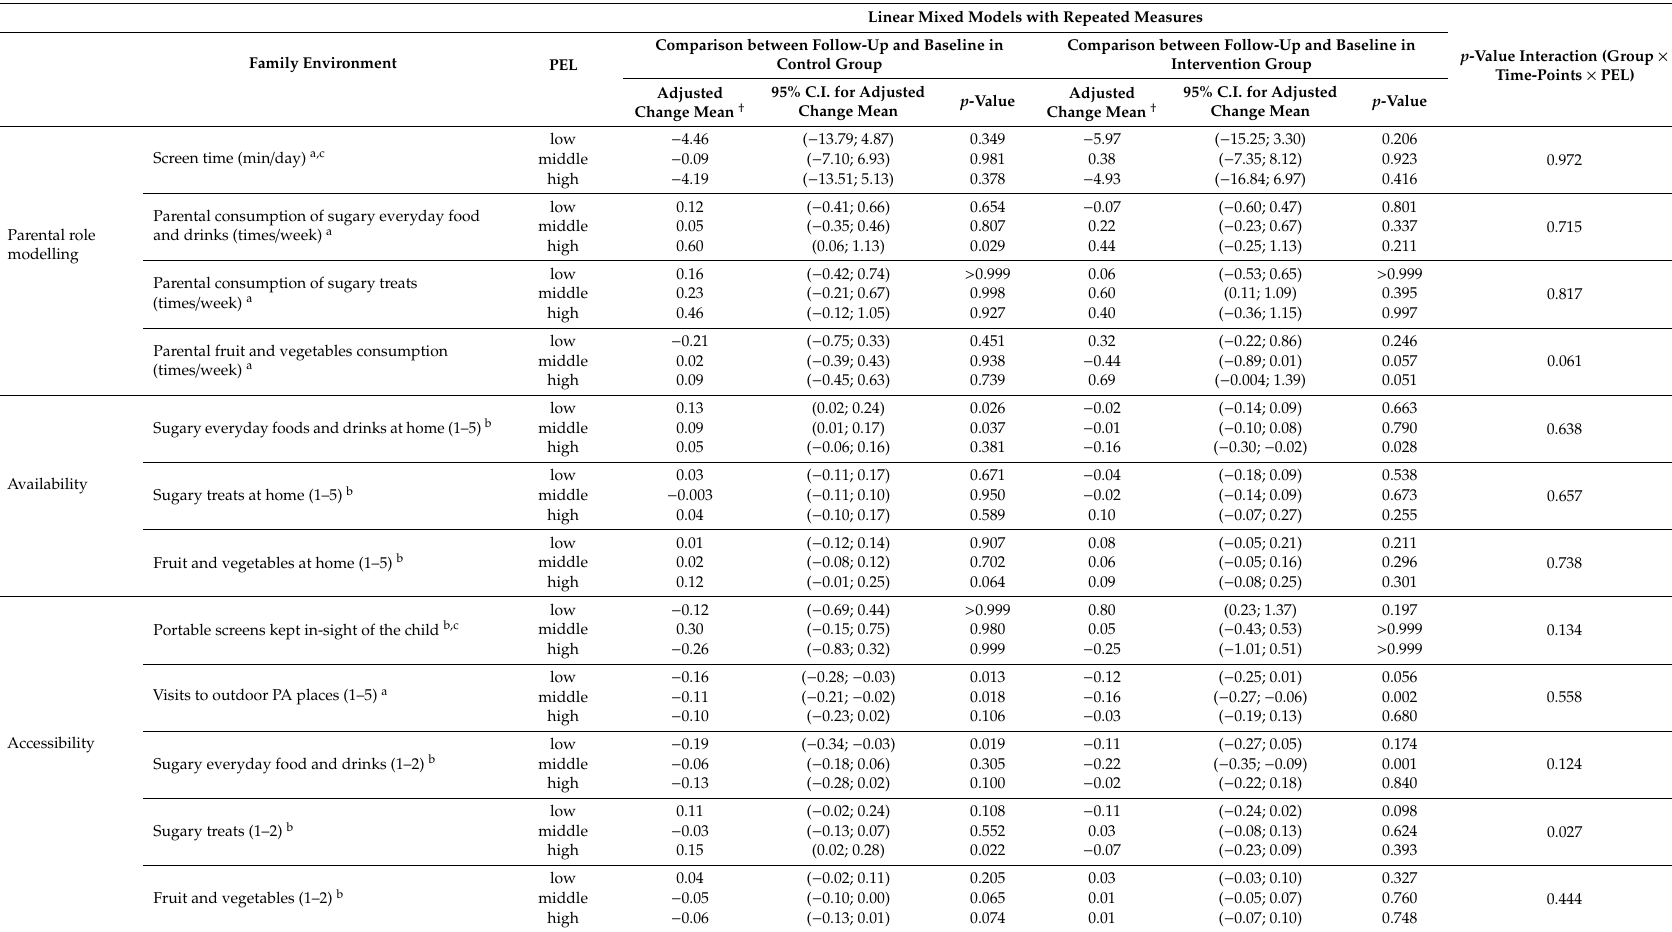
Table 5. Comparison of parental role modeling, availability and accessibility between baseline and follow-up in intervention and control groups separated by parental educational level (PEL) ( n =